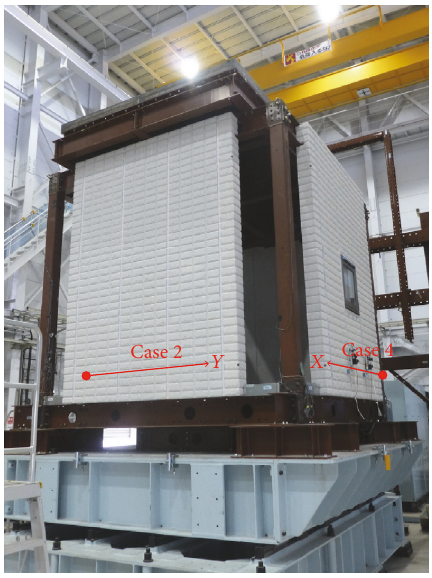
Figure 4: External views of Case 2 and Case 4 .